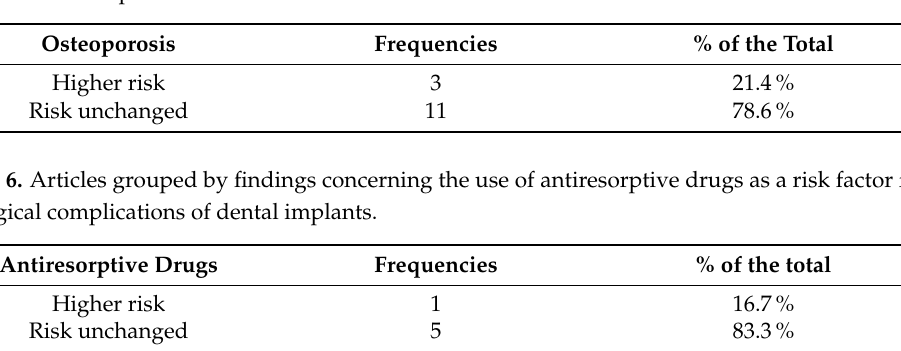
Table 5. Articles grouped by findings concerning osteoporosis as a risk factor for biological complica- tions of dental implants.